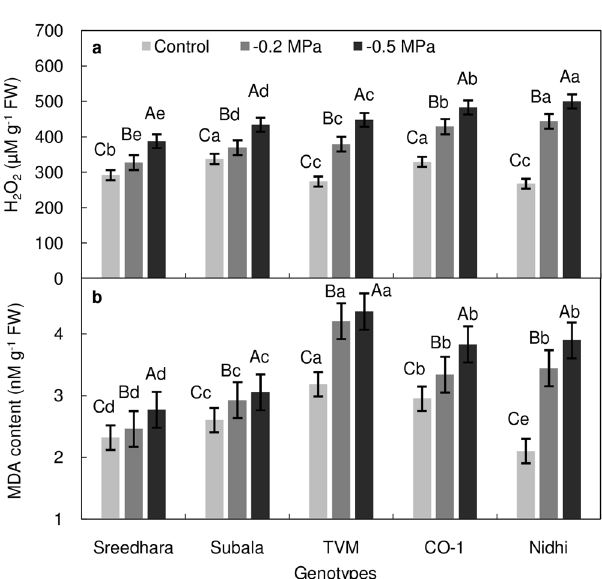
Figure 2. ( a–b ) Effect of in vitro PEG mediated osmotic stress on H 2 O 2 production ( a ) and lipid peroxidation ( b ) in leaf tissues of Chinese potato genotypes. Values are the mean of three replicates and bars represent standard error of means. Different letters in upper case represent significant differences between the treatments (control, –0.2 MPa and –0.5 MPa) in the genotypes and lower case represents significant difference among the genotypes under each treatment according to Tukey’s